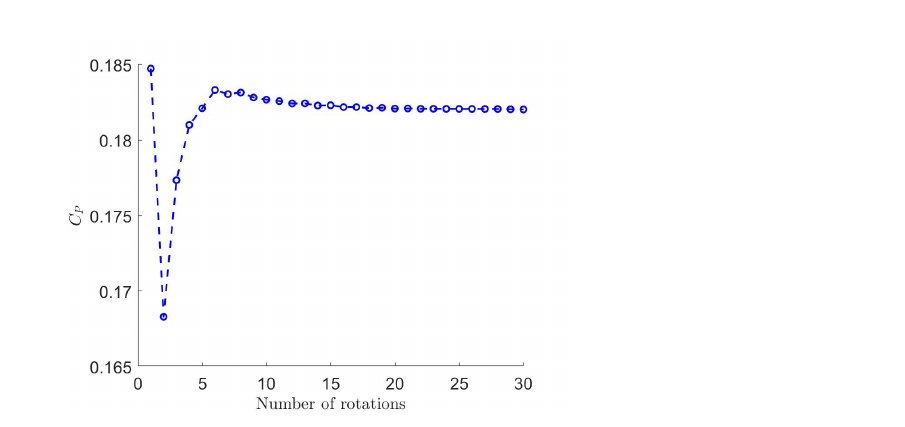
Figure 2. An example of the convergence behavior of C P . This example shows the results on a 1.3 million cell mesh at a time step of 1.25 × 10 − 4 s.